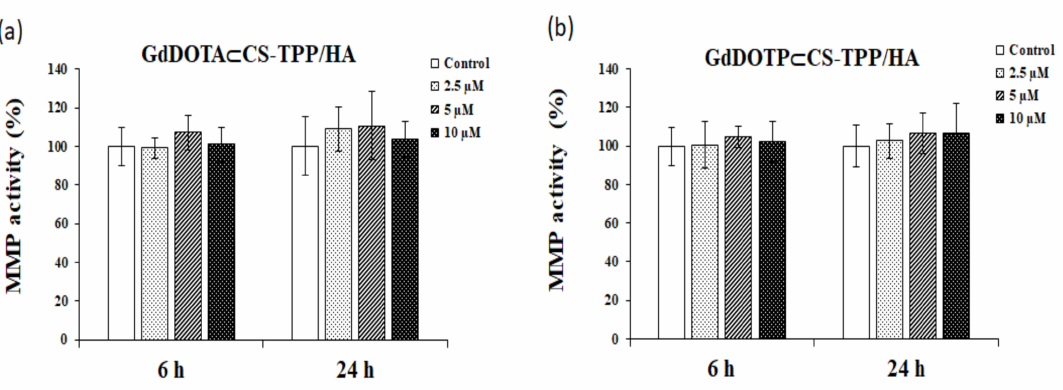
Figure 2. The level of mitochondrial membrane potential in RAW 264.7 murine macrophages cells after 6 -and 24 h of exposure to doses of 2.5, 5 and 10 µ M of ( a ) GdDOTA ⊂ CS-TPP/HA and ( b ) GdDOTP ⊂ CS-TPP/HA NGs. Untreated cells were used as a control. Data are expressed as mean ± SD ( n =